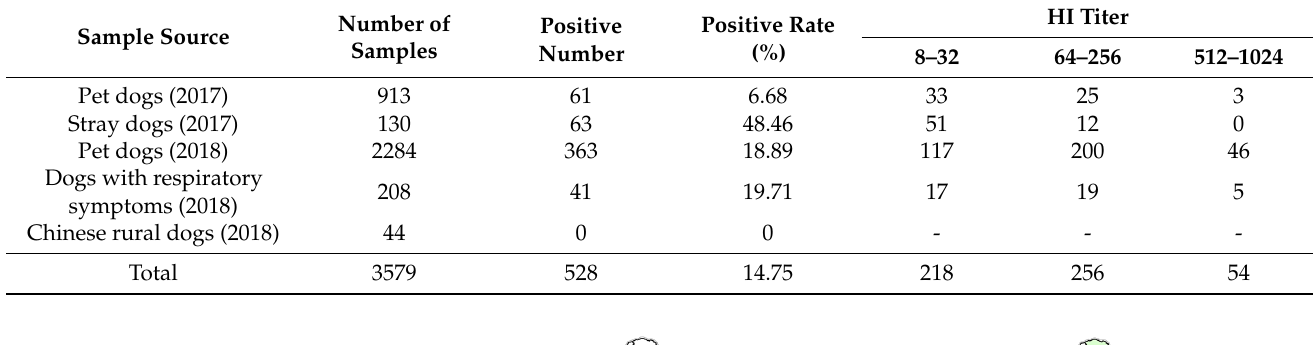
7 of 14 Figure 1. Phylogenetic tree of HA and NA sequences of H3N2: ( a ) phylogenetic tree of HA sequences of H3N2. ( b ) Phylo- genetic tree of NA sequences of H3N2. Red, blue, yellow, and green branches represent isolates from dogs, avian, swine, and humans, respectively. Black circles represent the strains in this study. 3.3. Seroepidemiological Investigation A total of 3579 dog serum samples from 27 provinces in China were screened by the HI assay for antibody reactivity against A/canine/Jilin/QiaoKe01/2017 (QK01(H3N2)). As shown in Table 1 and Figure 2, 528 (14.75%) dog serum samples were positive. The results